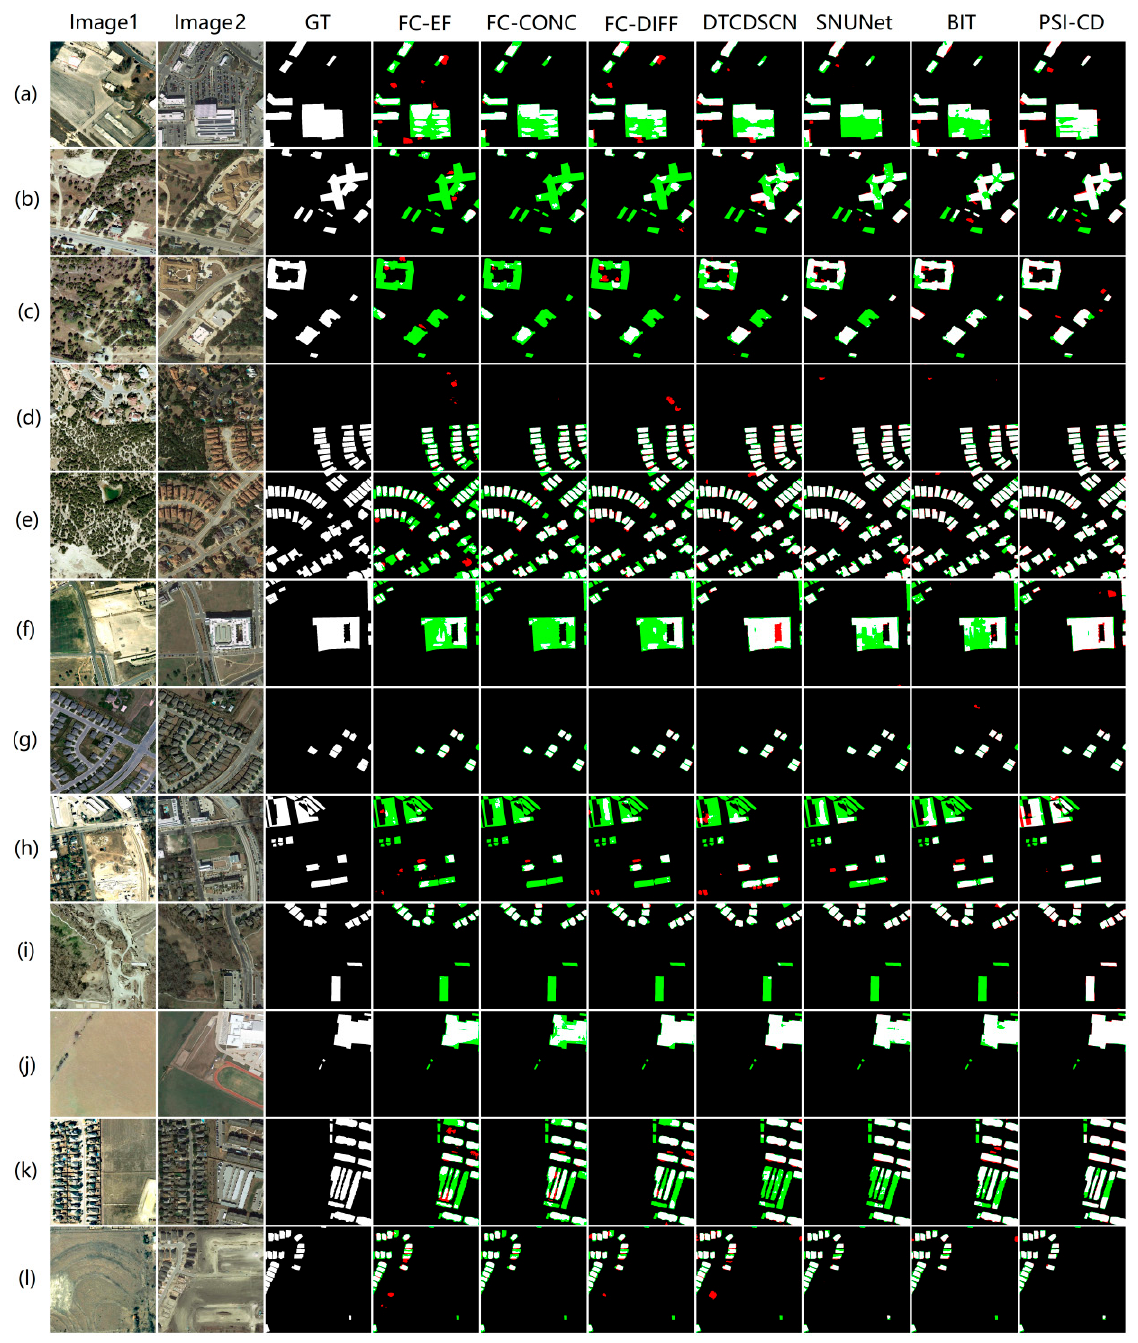
Figure 6. Experimental results of different methods on the LEVIR dataset. ( a – l ) are different types of building change detection results on the LEVIR dataset. White, black, red, and green represent true positive, true negative, false positive, and false negative, respectively.